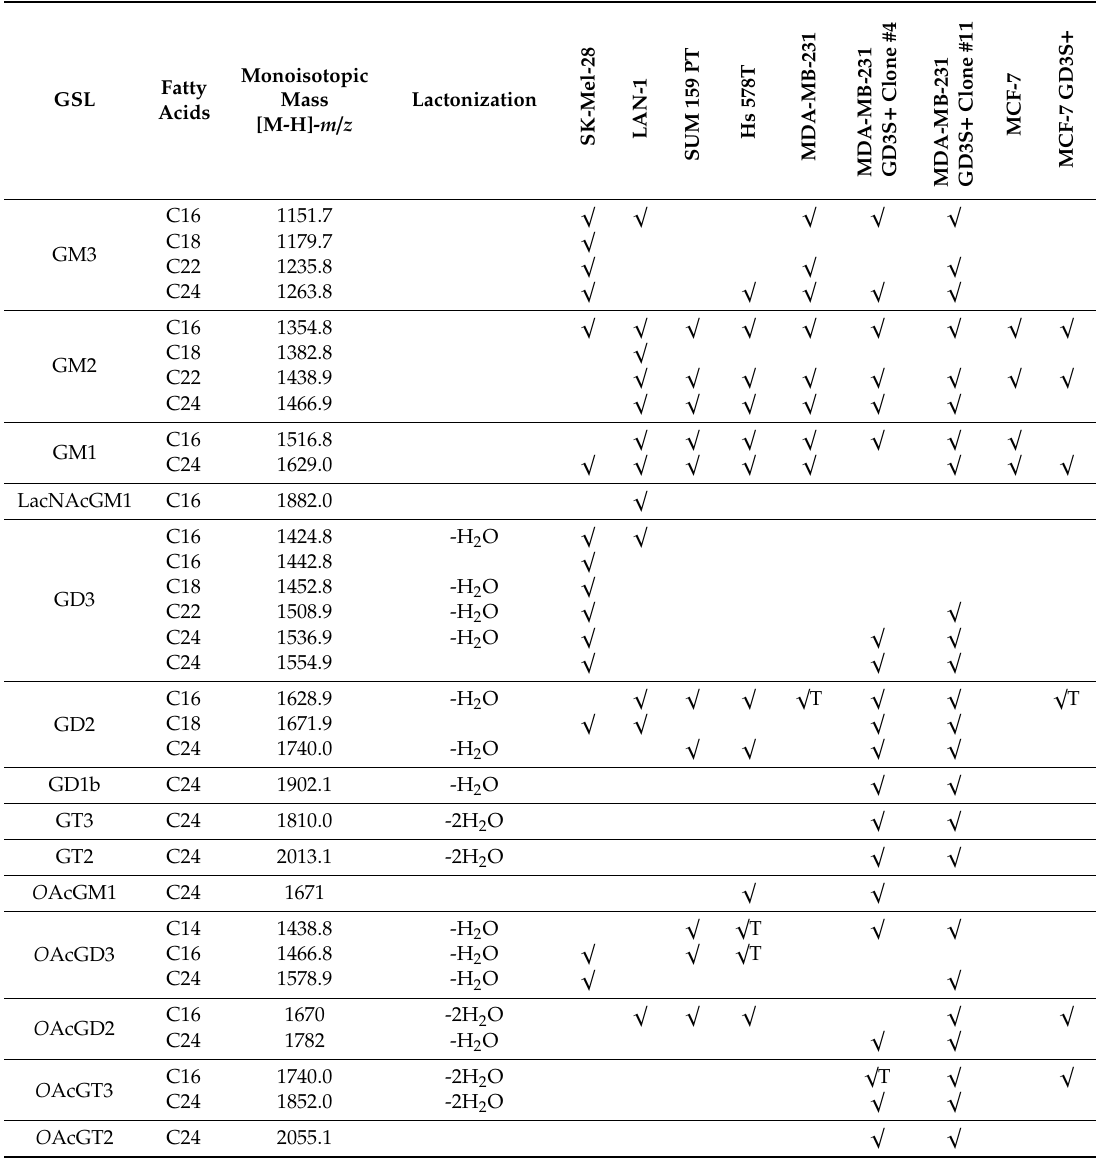
Table 1. List of identified gangliosides in neuroectoderm derived cells. Monosylalylated GSL are observed at [M − H] − . Di- and trisialylated GSL were mainly observed at m / z [M − H 2 O − H] − and [M − 2H 2 O − H] − . √ √ indicates the presence of GSL, and T indicates that GSL is present in traces